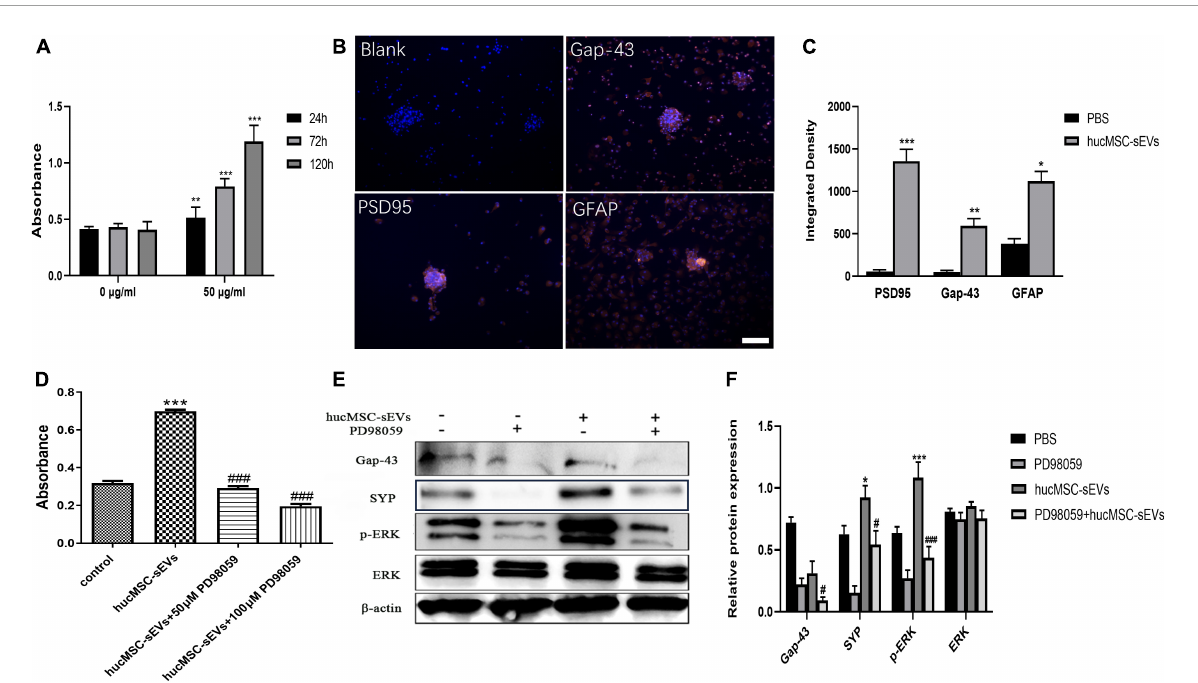
FIGURE5 hucMSC-sEVs promoted the proliferation and differentiation of NSCs through the ERK1/2 pathway. (A) The cell viability of NSCs treated with 0 and 50 µ g/mL hucMSC-sEVs was detected by MTS assays. (B) Representative immunofluorescence images of Gap-43, PSD-95, and GFAP staining. Scale bars, 100 µ m. (C) The quantitative analysis of integrated density of Gap-43, PSD-95, and GFAP in different groups. (D) The cell viability of NSCs treated with 50 µ g/mL hucMSC-sEVs and PD98059 was detected by MTS assays. (E) Representative western blot images showing the protein levels of Gap-43, SYP, ERK, p-ERK. (F) Quantification of protein expression. β -actin served as a loading control. The data are presented as means ± SD. n = 6 (A) ; n = 4 (D) ; n = 3 (C,F) ; ** p < 0.01,*** p < 0.001 vs. 0 µ g/mL group; * p < 0.05, ** p < 0.01, *** p < 0.001 vs. PBS group; *** p < 0.001 vs. control group, ### p < 0.001 vs. hucMSC-sEVs group; # p < 0.05, ### p < 0.001 vs. hucMSC-sEVs group, * p < 0.05, *** p < 0.001 vs. PBS